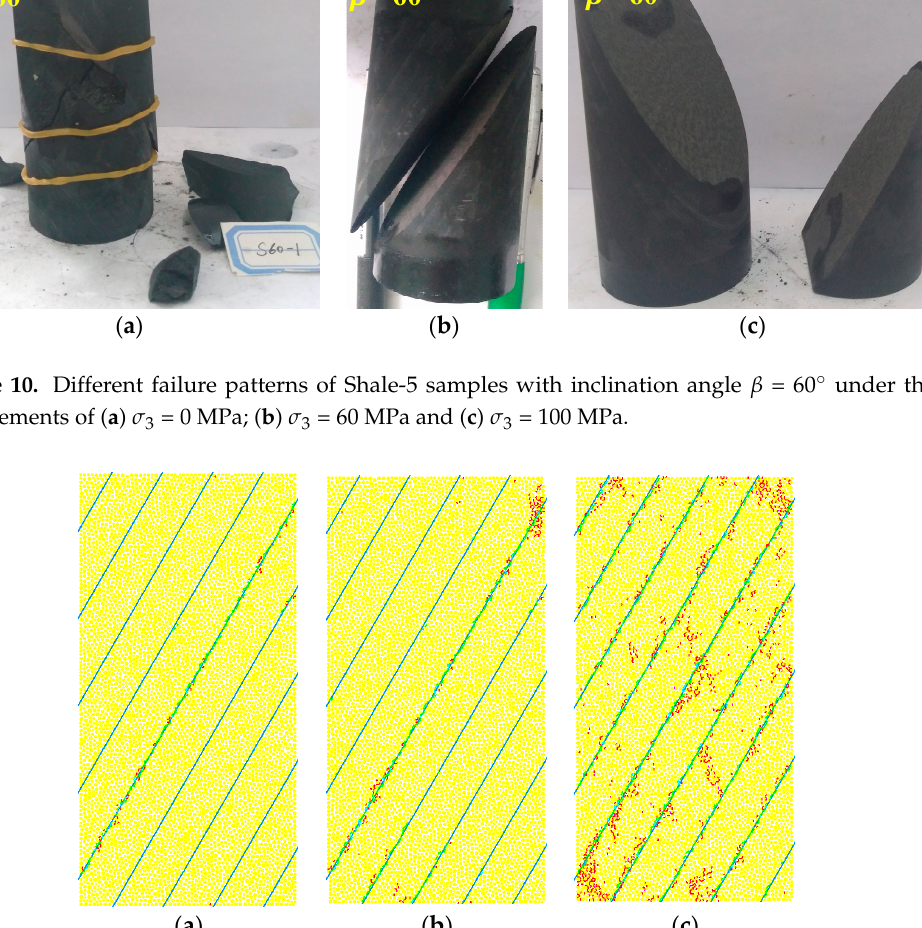
Figure 11. Different fracture characteristics of the samples with inclination angle β = 60 ◦ under confinement of 30 MPa by numerical simulations. ( a ) c w = 40 MPa, ϕ w = 10 ◦ ; ( b ) c w = 40 MPa, ϕ w = 30 ◦ ; and ( c ) c w = 40 MPa, ϕ w = 50 ◦ . Blue color shows the position of the weak planes; Red and magenta colors show the tensile and shear micro-cracks in the matrix; Cyan and green colors show the tensile and shear micro-cracks in the weak planes.